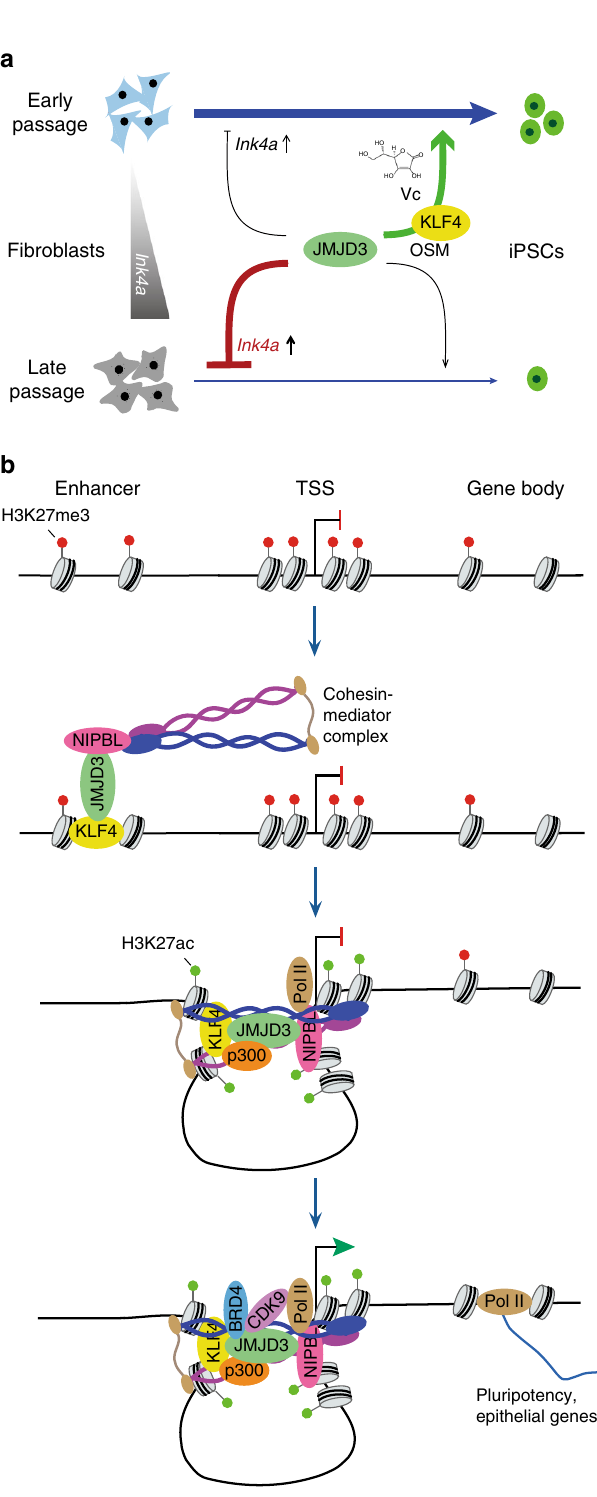
Fig. 7 Working model for JMJD3 and KLF4 in reprogramming. a JMJD3 positively and negatively regulates reprogramming in early and late passage fi broblasts respectively. b KLF4 recruits JMJD3 and co-factors to induce gene activation in